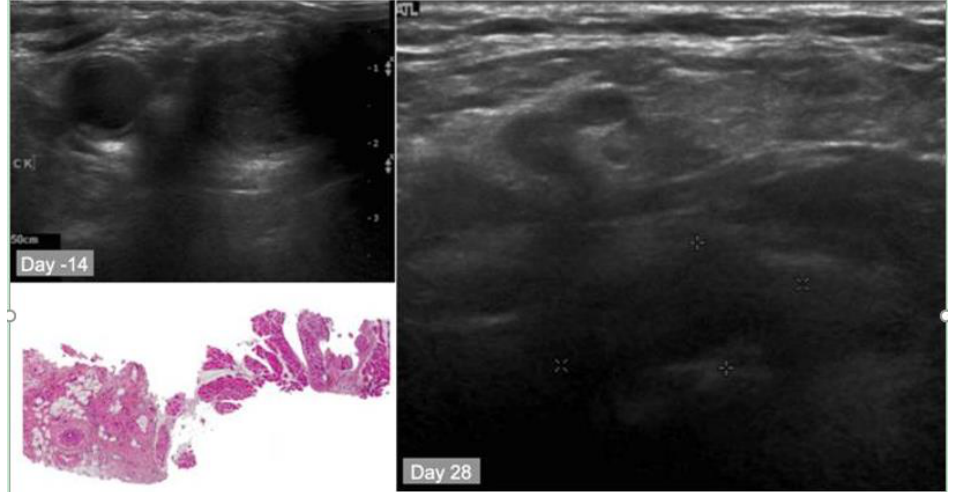
Figure 14. Sixty-one-year-old female with metastatic squamous cell carcinoma (SCC) to the torso (back) treated with PCI of bleomycin. The primary identified disease was in the tongue base with nodal involvement (cervical and axillary). The patient underwent radiotherapy and multiple rounds of chemotherapy for her tongue base carcinoma, which failed to control the disease. Left-hand column: the shielding around the lesion after including 10mm of macroscopically healthy looking tissue to eliminate any risk of micro-infiltration, followed by PCI surface illumination. Right hand column: the “target lesion” on day -14, day 28 and month 3, where complete response was achieved. For month 3, selective surgical biopsies acquired from the centre and peripheries were found to be tumour-free.